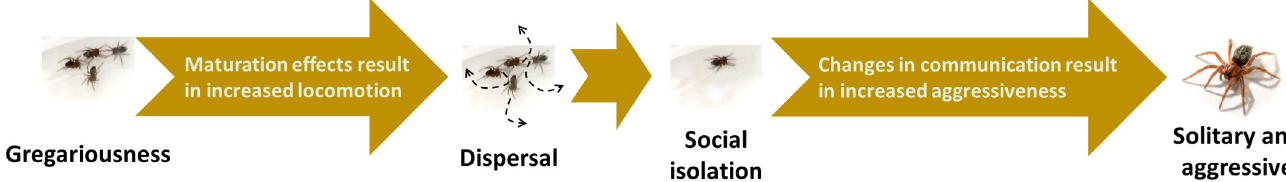
Fig 7. Schematic summary of the causal relationship between dispersal, social isolation and aggression. A maturational increase in mobility in gregarious spiderlings triggers dispersal that results in social isolation, which, in turn, elicits aggression due to changes in the way individuals responded to signals from